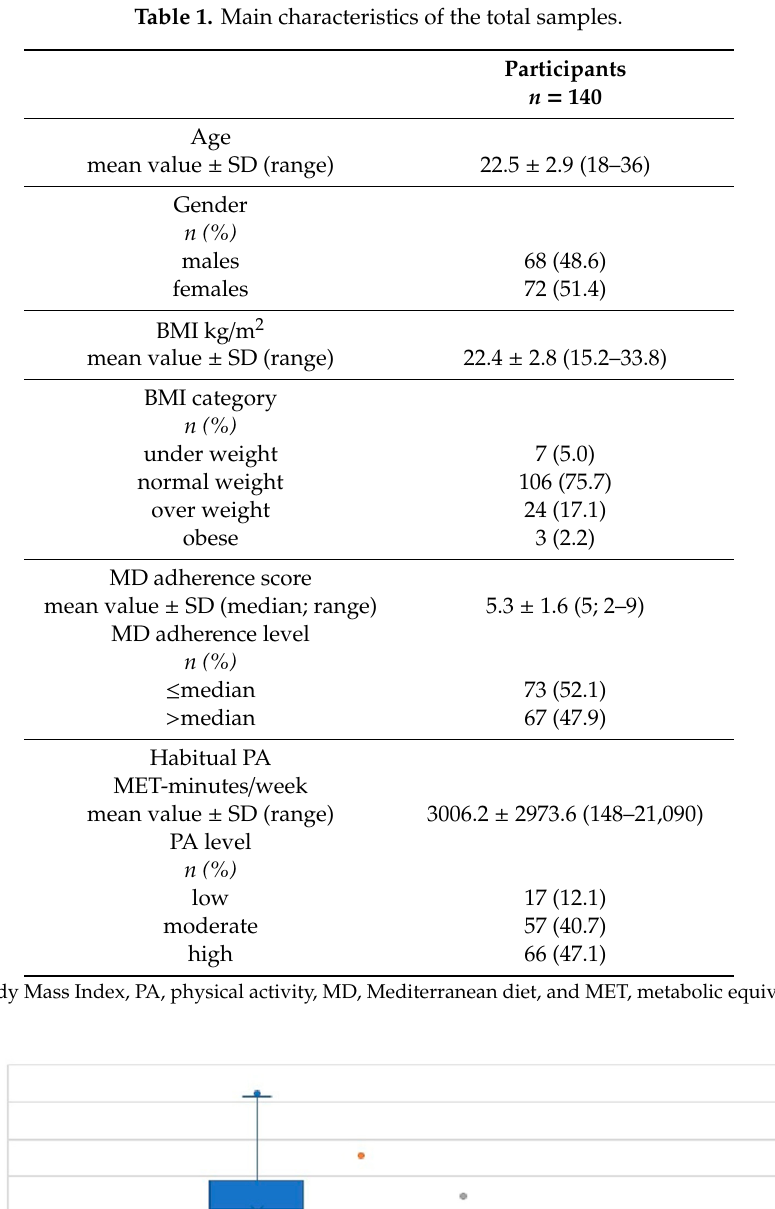
were found. Table 2. Comparisons of the Shannon index, Firmicutes , Bacteroidetes , and the Firmicutes / Bacteroidetes (F/B) ratio of the BMI, MD score, and PA level groups, with corresponding p -values. BMI